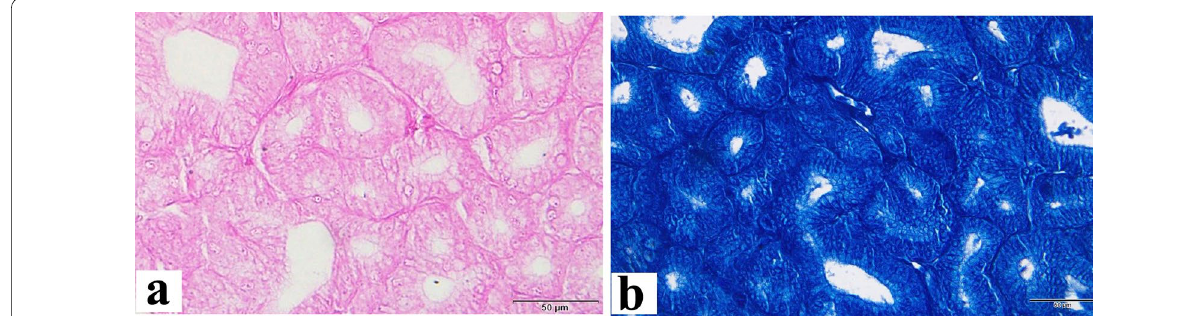
Fig. 5 A photomicrograph of a transverse section of the Harderian gland of Egyptian agama, Trapelus mutabilis , showing a glandular cells give a weakly positive reaction with PAS and b a bluish color with alcian blue at pH 2.5 (